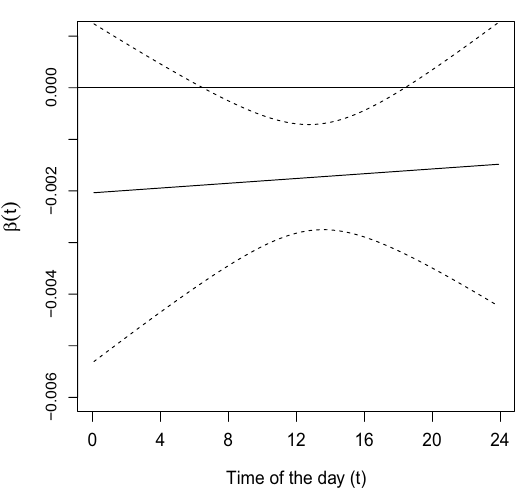
Figure 5. Estimated diurnal effect β( t ) of L i 3 ( t ) of PA on log odds of